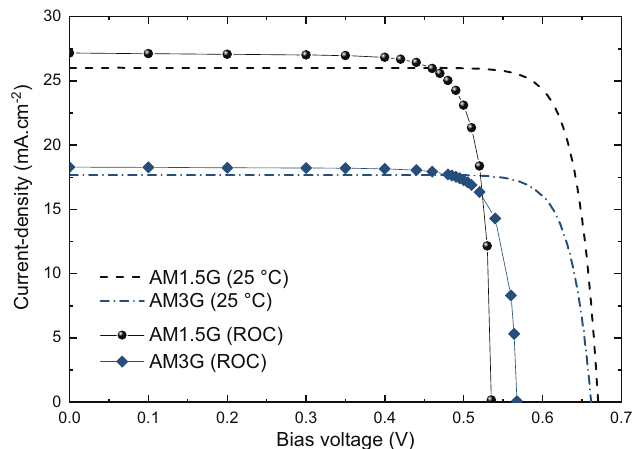
Fig. 6. Current – voltage characteristic of the reference cell under AM 1.5G and AM 3G spectra. The dashed lines correspond to a fi xed cell temperature (25 ° C) whereas the solid lines correspond to the current-voltage characteristic under